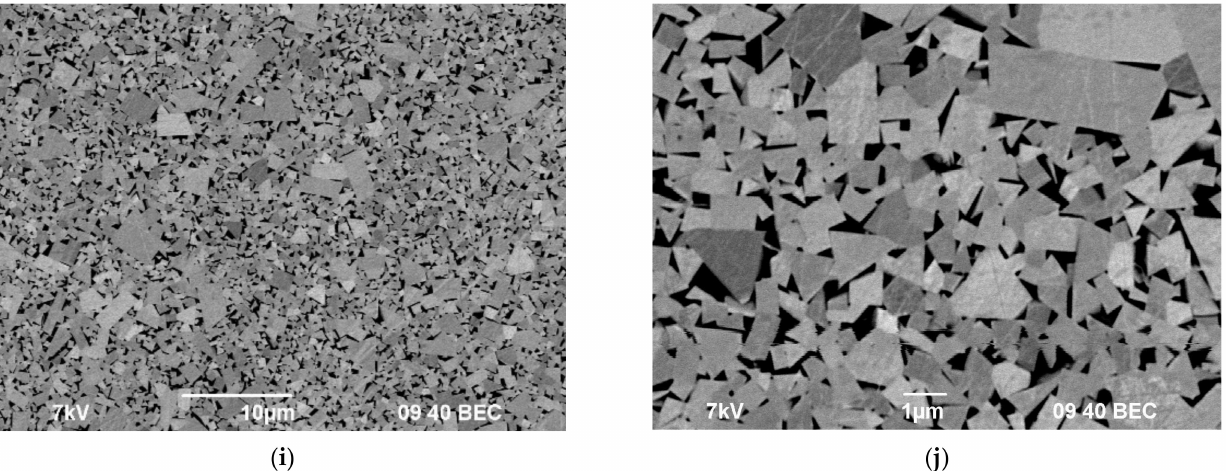
Figure 5. Microstructure of WC-10Co hard alloys obtained by liquid-phase SPS with various concentrations of graphite: 0.1 ( a , b ), 0.2 ( c , d ), 0.3 ( e , f ), 0.4 ( g , h ) and 0.5 wt.% ( i , j ). In the photographs with high magnifications ( b , d , f , h , j ), images of the fine-grained matrices (without the abnormally large grains) are